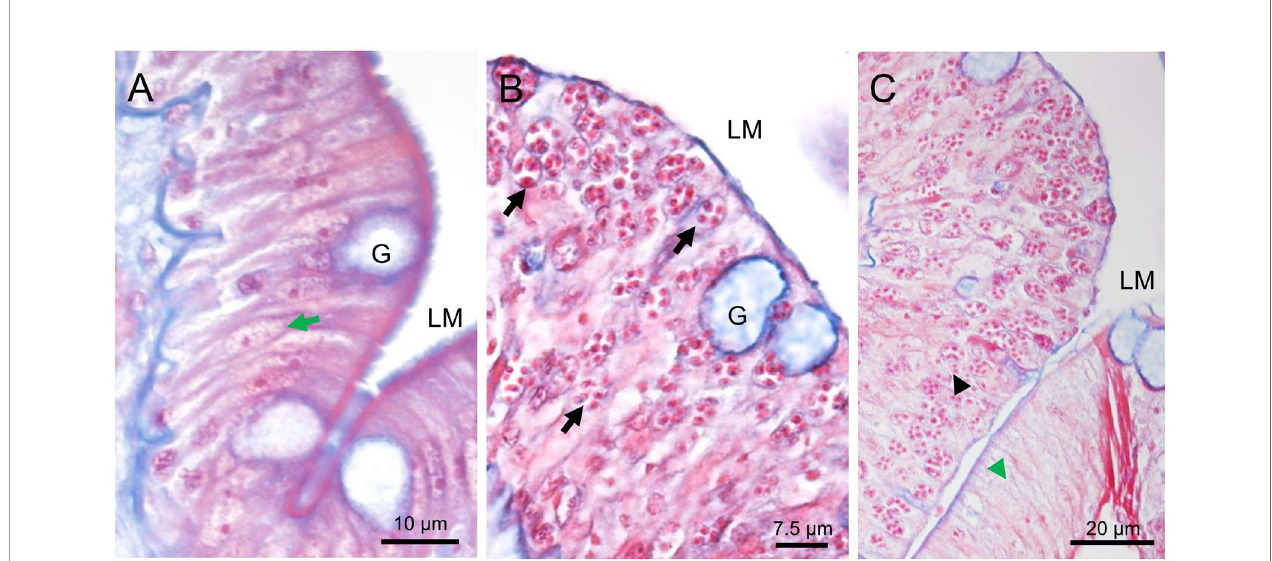
FIGURE 2 | Histopathology of Nucleospora hippocampi n. sp. infection in the intestinal epithelia of the Hippocampus erectus . Masson ’ s stain. (A) Normal columnar epithelium of the intestine: intestinal lumen (LM), host nucleus (green arrow), and goblet cell (G). (B) The intestinal epithelium with microsporidian infection (black arrows). (C) The infected region (black arrowhead) and uninfected region (green arrowhead) of the intestinal epithelium